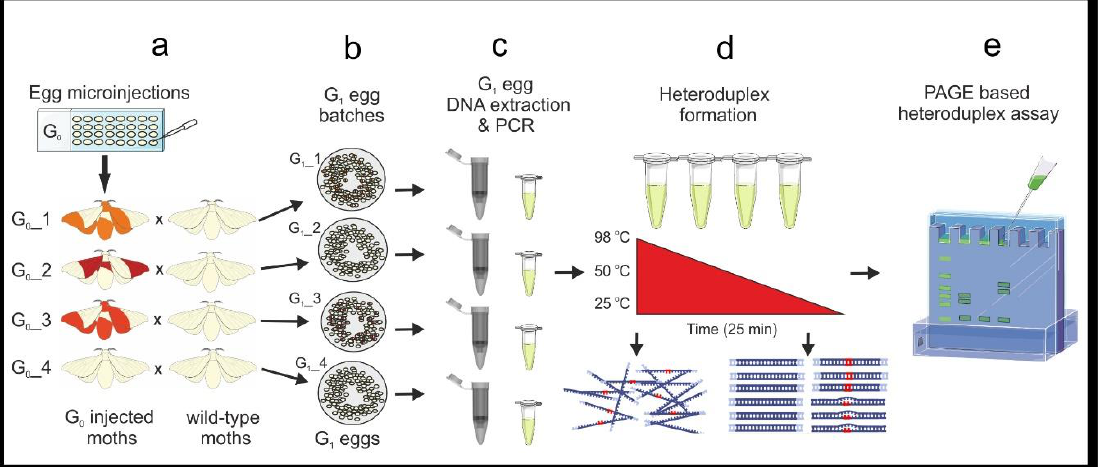
Figure 2. A workflow for the initial identification of mutations. ( a ) G 0 injected eggs are reared following microinjection and crossed with wildtype moths to generate ( b ) G 1 egg batches. ( c ) DNA extraction and PCR are performed on eggs from G 1 egg batches followed by ( d ) temperature denaturing and heteroduplex formation. ( e ) A PAGE-based heteroduplex assay is performed to identify which egg batches contain mutations. In this scheme G 0 _1 and G 0 _3 moths carry mutations in germline cells and give rise to mutant G 1 progeny. G 0 _2 moth carries somatic mutations which are not transmitted to the G 1 progeny. G 0 _4 lacks any mutation.